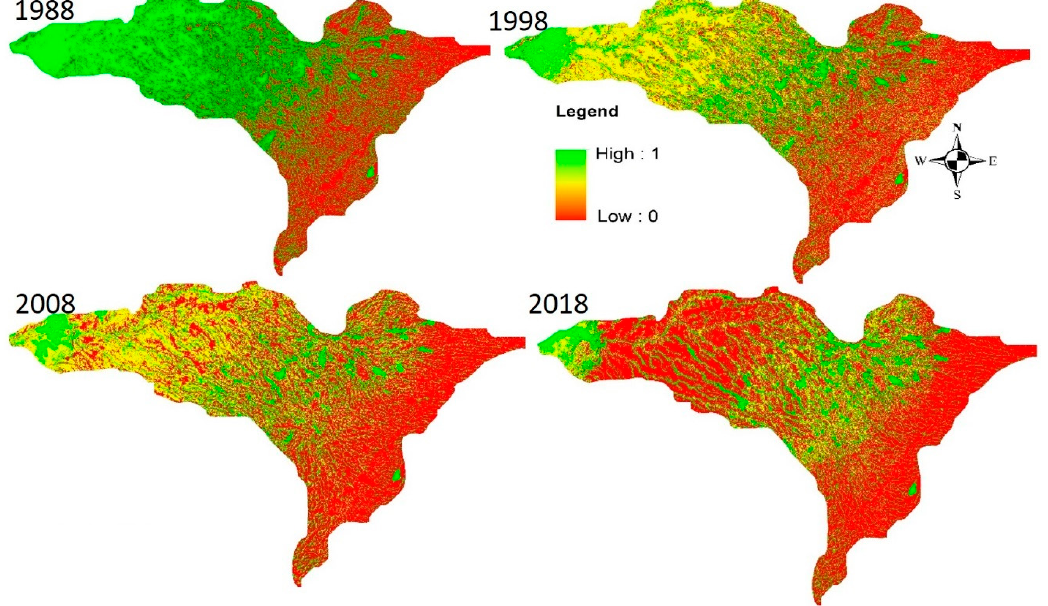
Figure 9. Mapping and trend of habitat quality.